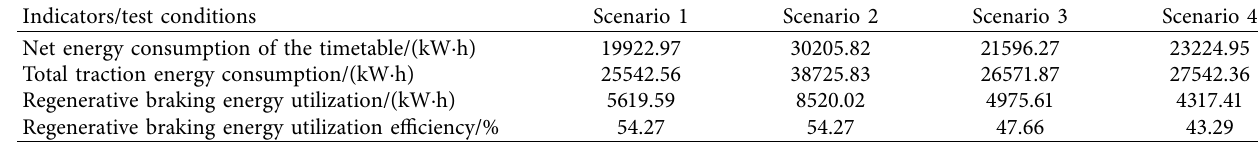
Table 4: Comparison of energy-saving effects under the four Scenarios.